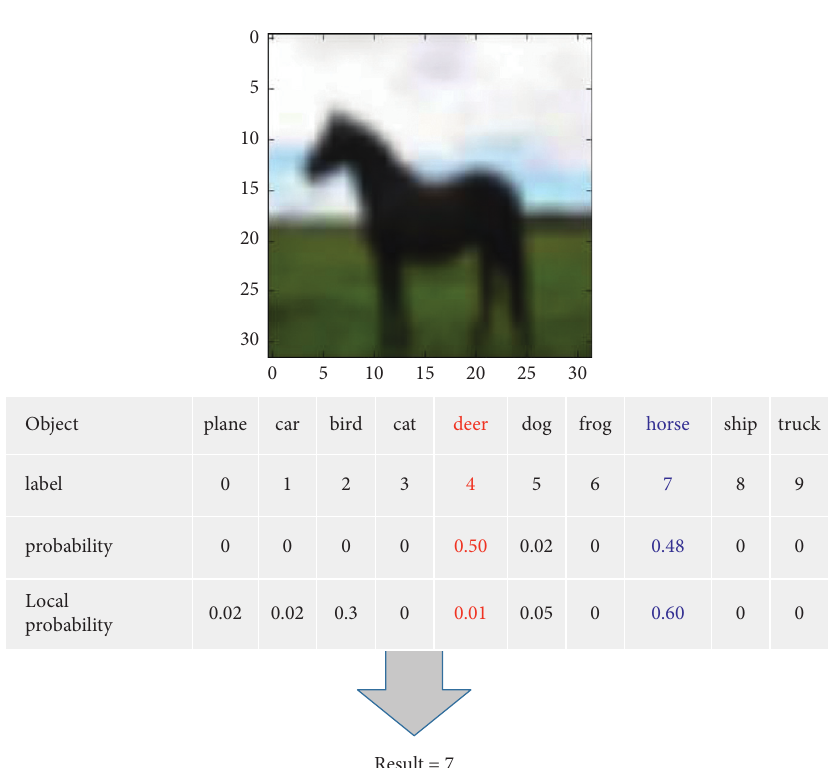
Figure 8: The result by the model is 4 (deer, wrong), but our framework can get the one that is 7 (horse, correct). Table 7: The introduction of the employed acronyms.